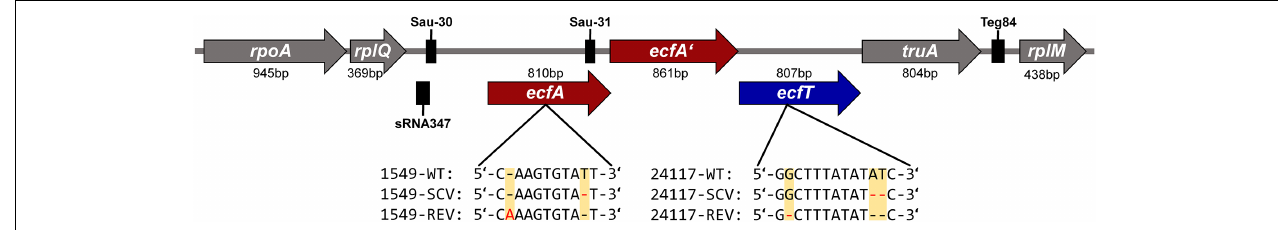
FIGURE 3 | Gene arrangement of the ecf modules of S. aureus strain triplets 1549 and 24117. The mutation locus within the corresponding strain and the resulting DNA profiles of the respective phenotypes are indicated. Black boxes represent small non-protein-coding RNAs Sau-30 (63 nucleotides), Sau-31 (65 nucleotides), Teg84 (79 nucleotides), and sRNA347 (91 nucleotides) (Abu-Qatouseh et al., 2010; Beaume et al., 2010; Howden et al., 2013). Among the e cf modules of the WTs of 1549 and 24117, there were 137 mismatches, 1 insertion (1 nucleotide), and 1 deletion (1 nucleotide). ecfA and ecfA’ , ECF transporter ATPases; ecfT , ECF transporter; rplM , 50S ribosomal protein L13; rplQ , 50S ribosomal protein L17; rpoA , DNA-directed RNA polymerase, alpha subunit; and truA , tRNA pseudouridine synthase